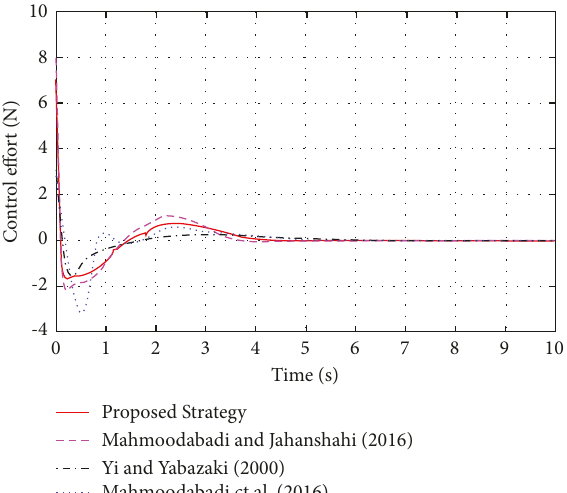
Figure 9: Control efforts based on the suggested fuzzy-PID controller and the techniques presented in references [28–30].